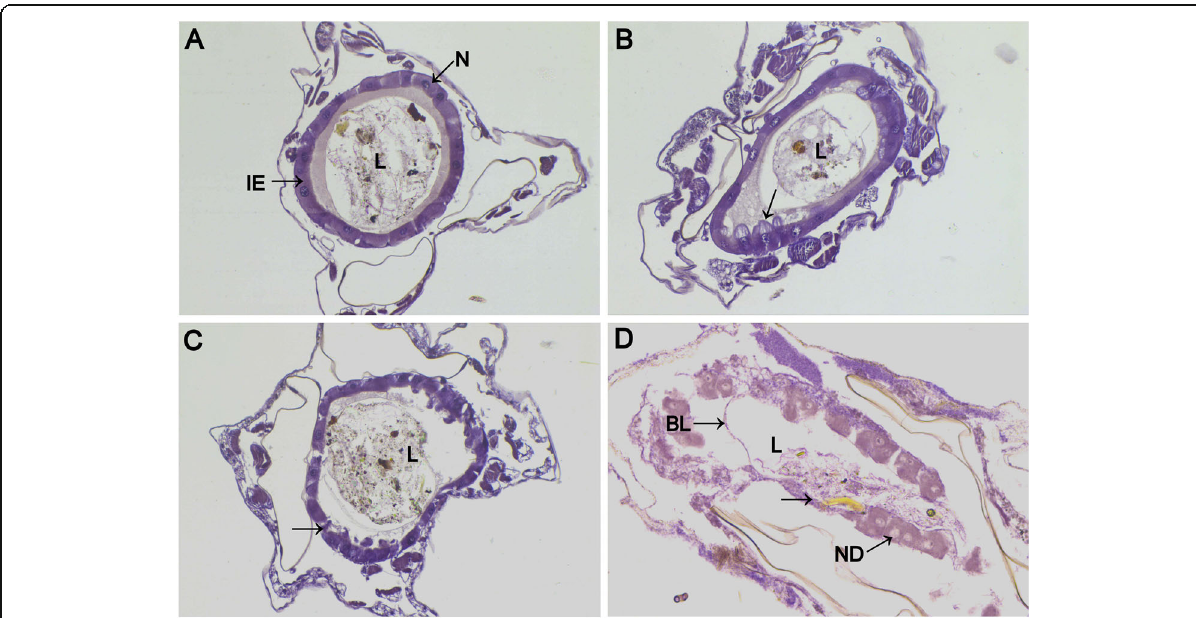
Fig. 3 Cross-sections of A. aegypti larvae midgut depicting different stages of deterioration after weed extract treatment. A Normal midgut or control (stage 1 = − ) with intact flattened cells, their dark nucleus, and clear cytoplasm. B Swelling of cells cytoplasm or vesicle formation (stage 2 = +). Arrow indicates swelling of cells. C Loss of cell-cell contact, damage of cell membrane, and distortion of cell and nucleus integrity (stage 3 = ++). Arrow indicates cell membrane/contact damage. D Complete damage of epithelium, disorganized cells, loss of cell-cell contact, and detachment of cells and basal lamina (stage 4 = +++). Note the cell and basil lamina detachment. Arrow indicates loss of cell integrity (L = intestinal lumen, IE = intestinal epithelium, BL = basal lamina; N = nucleus; DN = cell with damages nucleus)